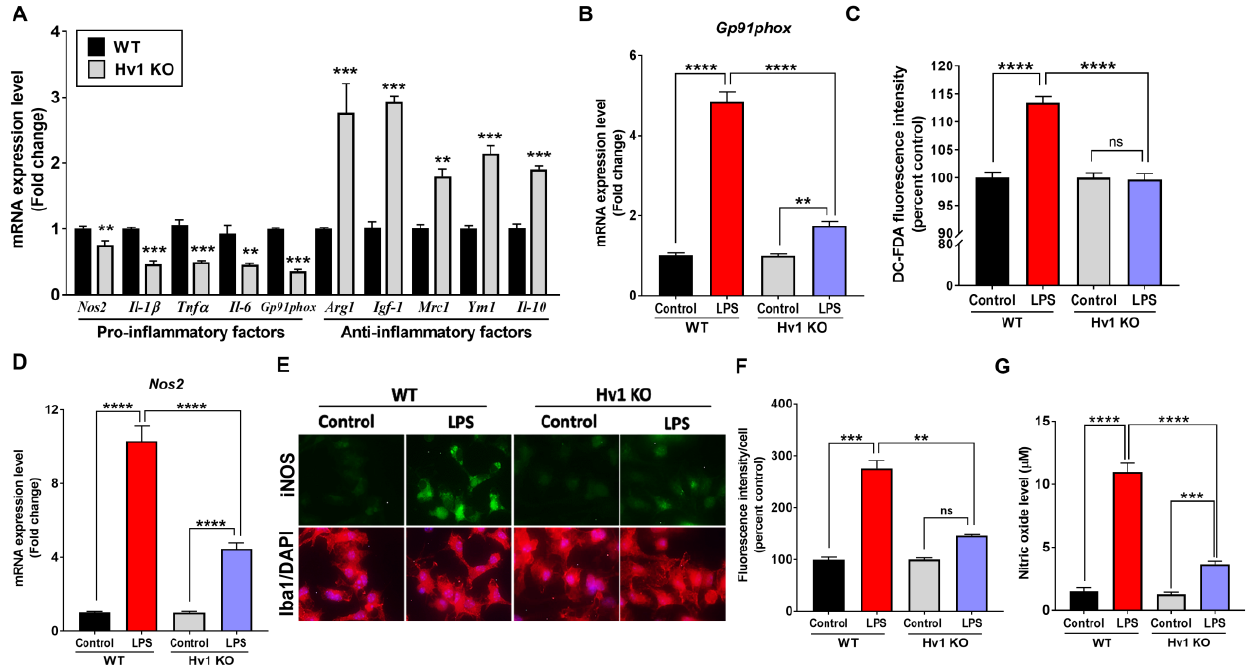
Figure 7. Hv1 KO attenuates LPS-induced reactive oxygen and nitrogen species generation in primary mouse microglia. ( A ) Basal gene expression of M1- or M2-related factors in WT versus Hv1 KO primary microglia via qPCR. ** p < 0.01, and *** p < 0.001 using SEM by Student’s t -test. ( B , C ) Hv1 KO primary microglia have reduced ROS generation following LPS treatment compared to WT control microglia, measured by Gp91phox gene expression ( B ) and intracellular ROS generation measured by the fluorescent CM-H 2 DCFDA dye ( C ). Hv1 KO primary microglia have reduced Nos2 gene expression ( D ) following LPS treatment compared to WT control microglia treated with LPS. Representative immunofluorescent images ( E ) for iNOS (green) in Iba1-positive (red) cells following LPS treatment in WT and Hv1 KO primary microglia, along with DAPI nuclear stain (blue) (scale bar 20 μm), with iNOS fluorescent intensity quantification ( F ), and media nitrite levels ( G ) measured by the colorimetric Griess assay. n = 3 isolations for all experiments. Asterisks denote statistically significant differences, ** p < 0.01, *** p < 0.001, and **** p < 0.0001, using two-way ANOVA followed by Tukey’s multiple comparisons. ‘ns’ indicates not statistically significant. Error bars denote the standard error of the